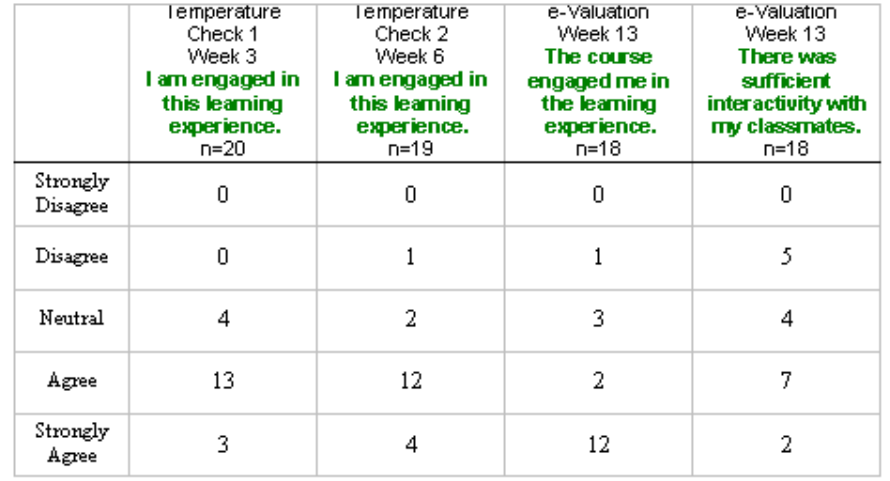
Table 2. Perceptions of engagement and